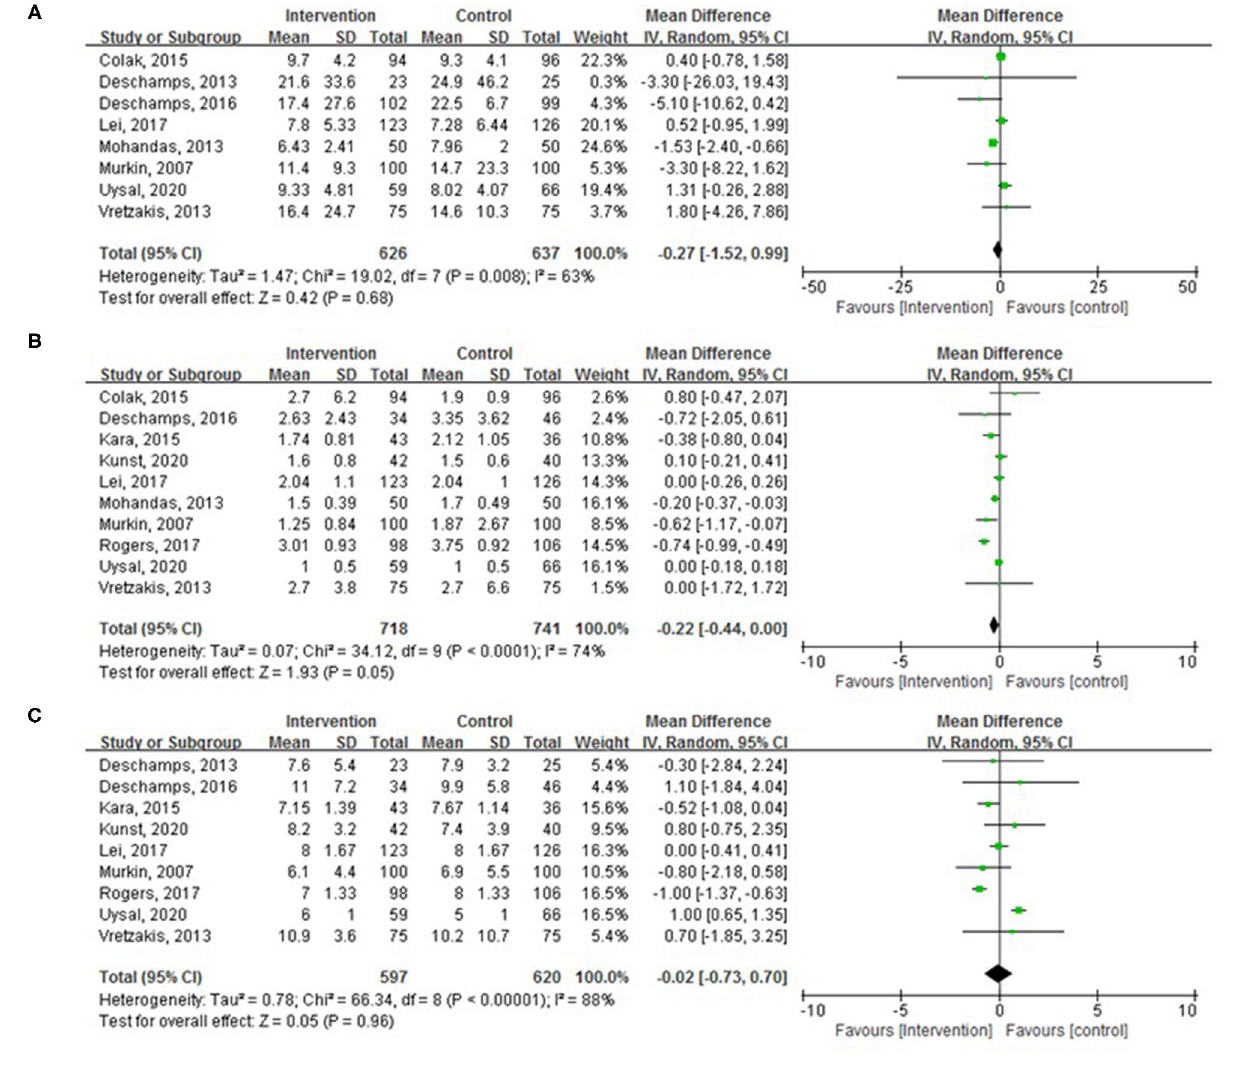
− 0.56 vs. − 0.05; p = 0.06 for a subgroup difference), with DM (WMD: − 0.72 vs. − 0.12; p < 0.001 for a subgroup difference), and CVA (WMD: − 0.72 vs. − 0.05; p < 0.001 for a